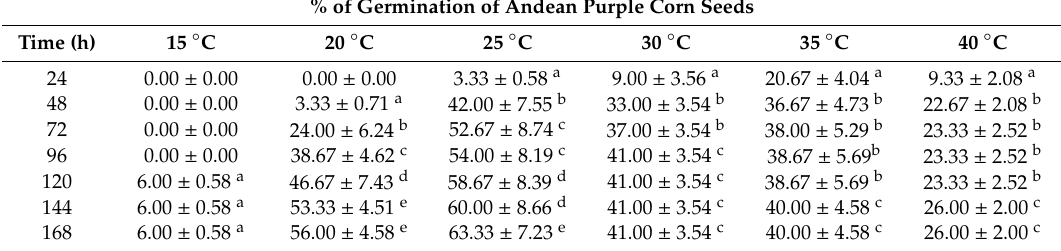
Table 1. Percentage germination at di ff erent time and temperature combinations of Andean purple corn seeds.